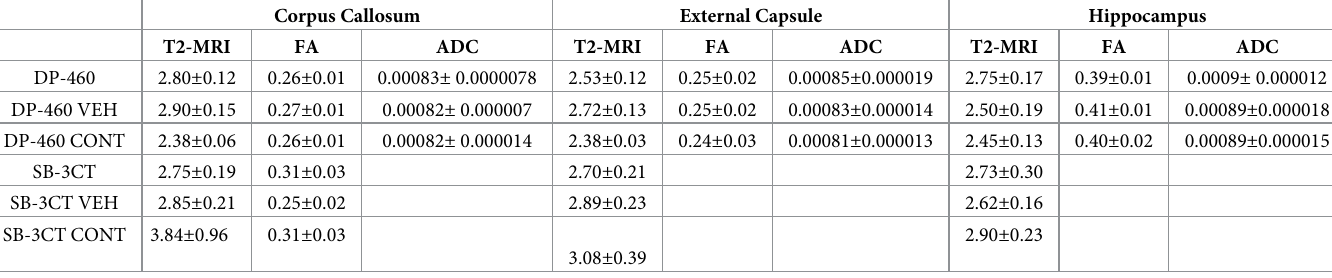
Table 1. MRI modalities are unchanged between treatment and control groups for DP-460 and SB-3CT studies.